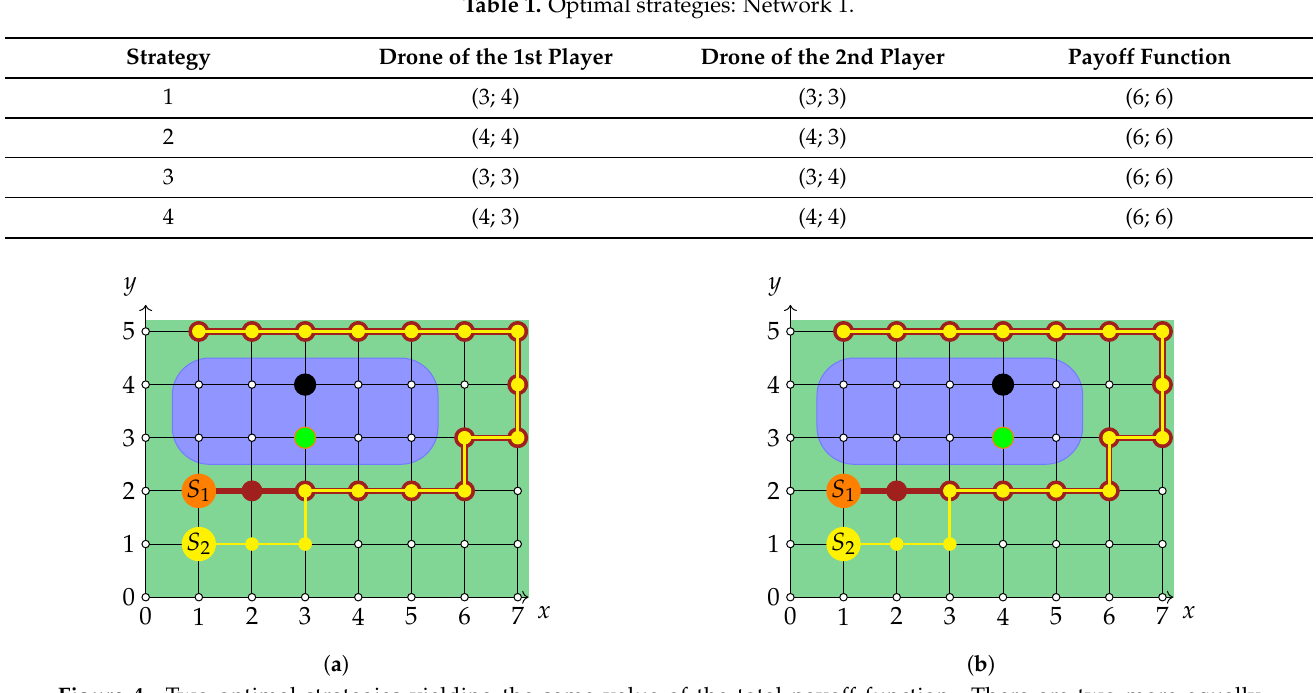
Figure 4. Two optimal strategies yielding the same value of the total payoff function. There are two more equally optimal solutions that differ from the shown ones by the reverse order of the drones. ( a ) strategy ( 3;4 ) / ( 3;3 ) ; ( b ) strategy ( 4;4 ) / ( 4;3 ) .